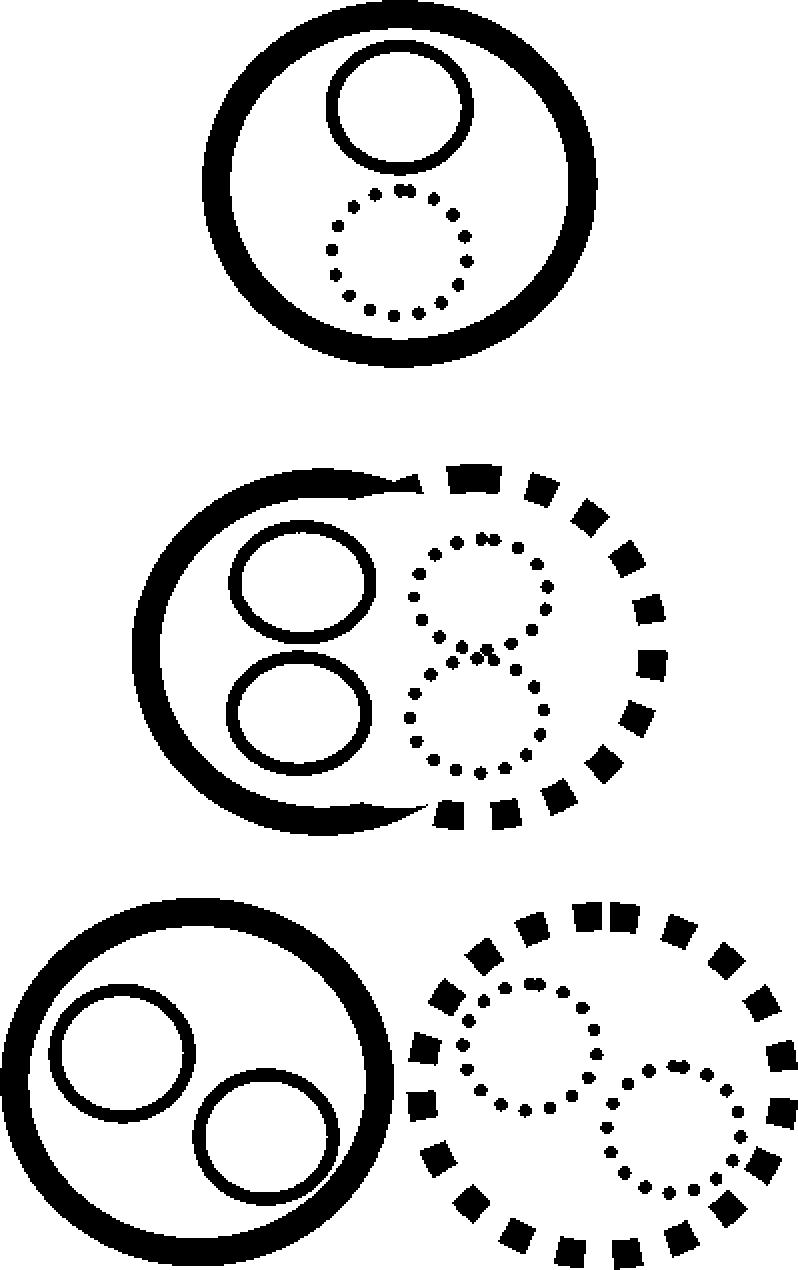
The obligate human pathogen,
Neisseria gonorrhoeae, has multiple genome copies per cell, which may be necessary for antigenic diversity and survival within the human host.